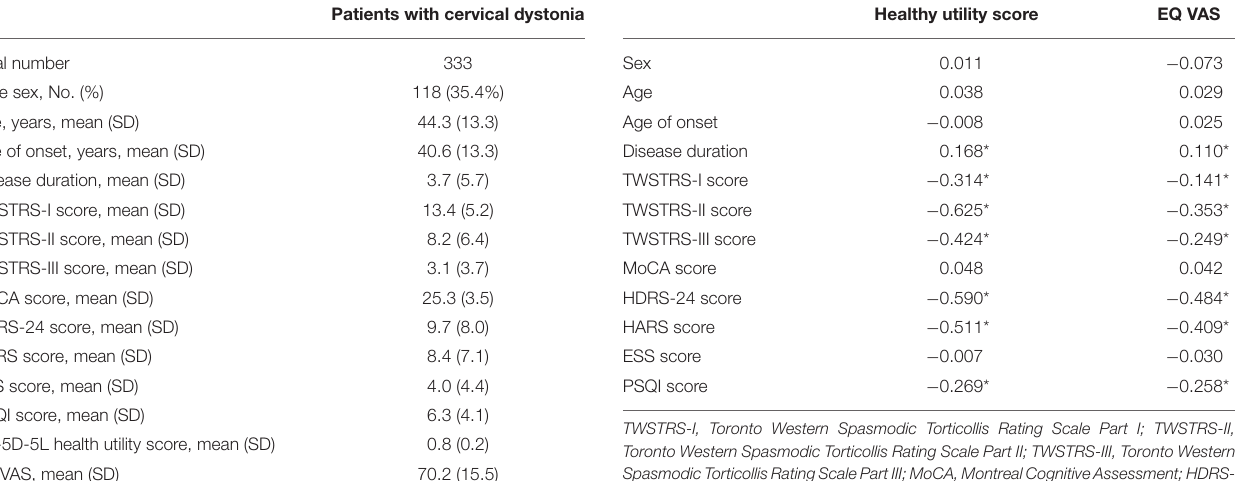
TABLE 2 | Spearman’s correlation analyses of the EQ-5D-5L healthy utility score and the EQ VAS score in patients with cervical dystonia. Patients with cervical dystonia Healthy utility score